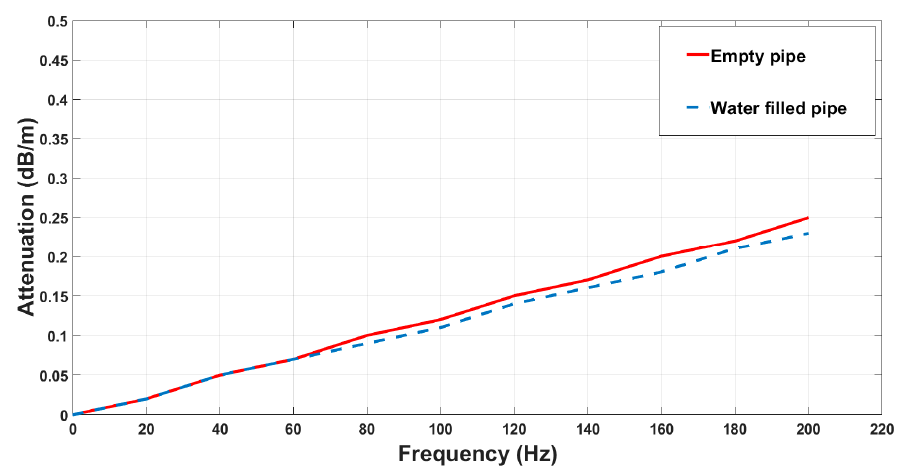
Table 3. Average SNR (dB) at each circumferential position around and axial distance along the exposed (empty) MDPE pipe.